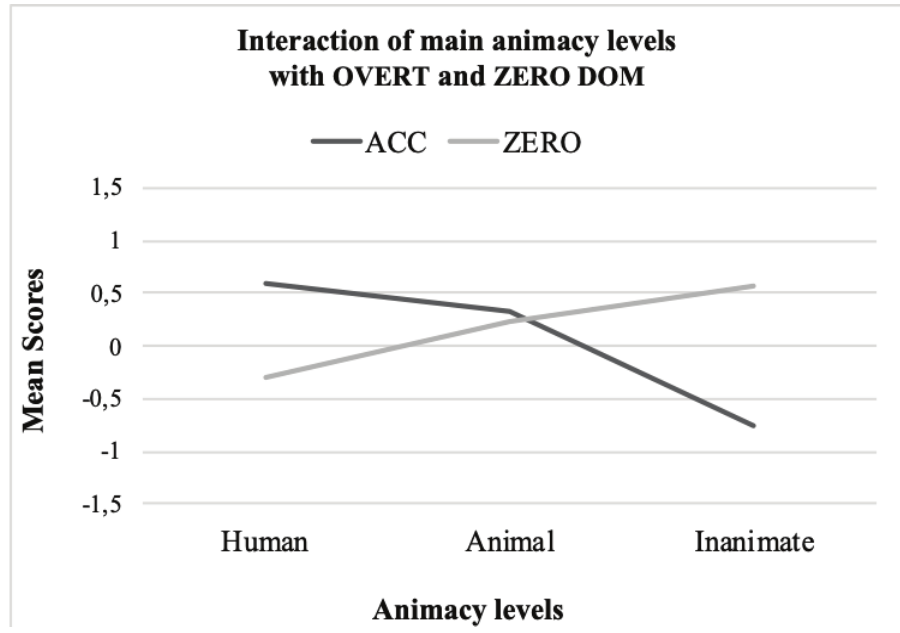
F igure 4. Interaction of the animacy categories with overt and zero marking of DOM.